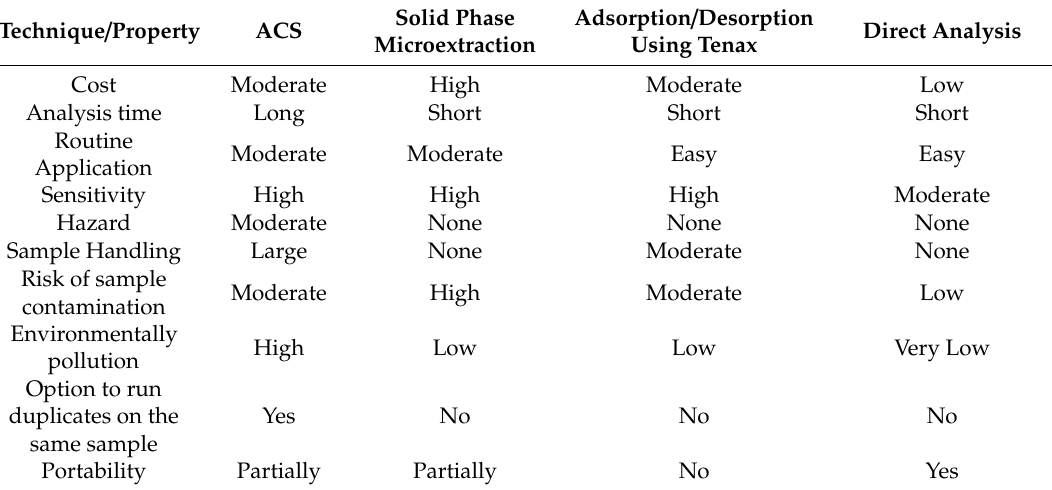
Table 1. Properties of the di ff erent pretreatment